Question: Looking at the figure, what chart type is it?
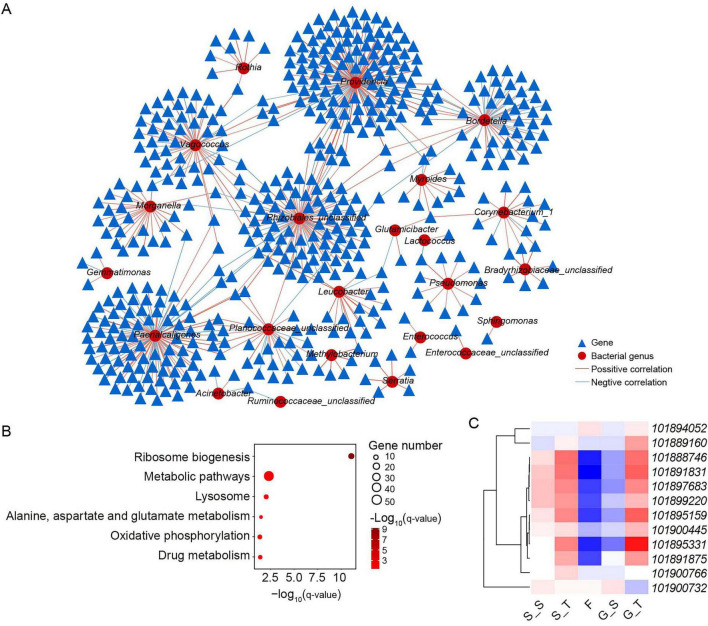
Answer: heatmap